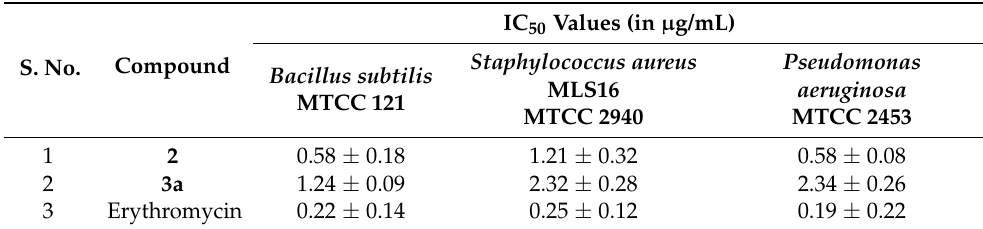
Table 3. Antibiofilm activities of the oxazolidinone derivatives, 2 and 3a .